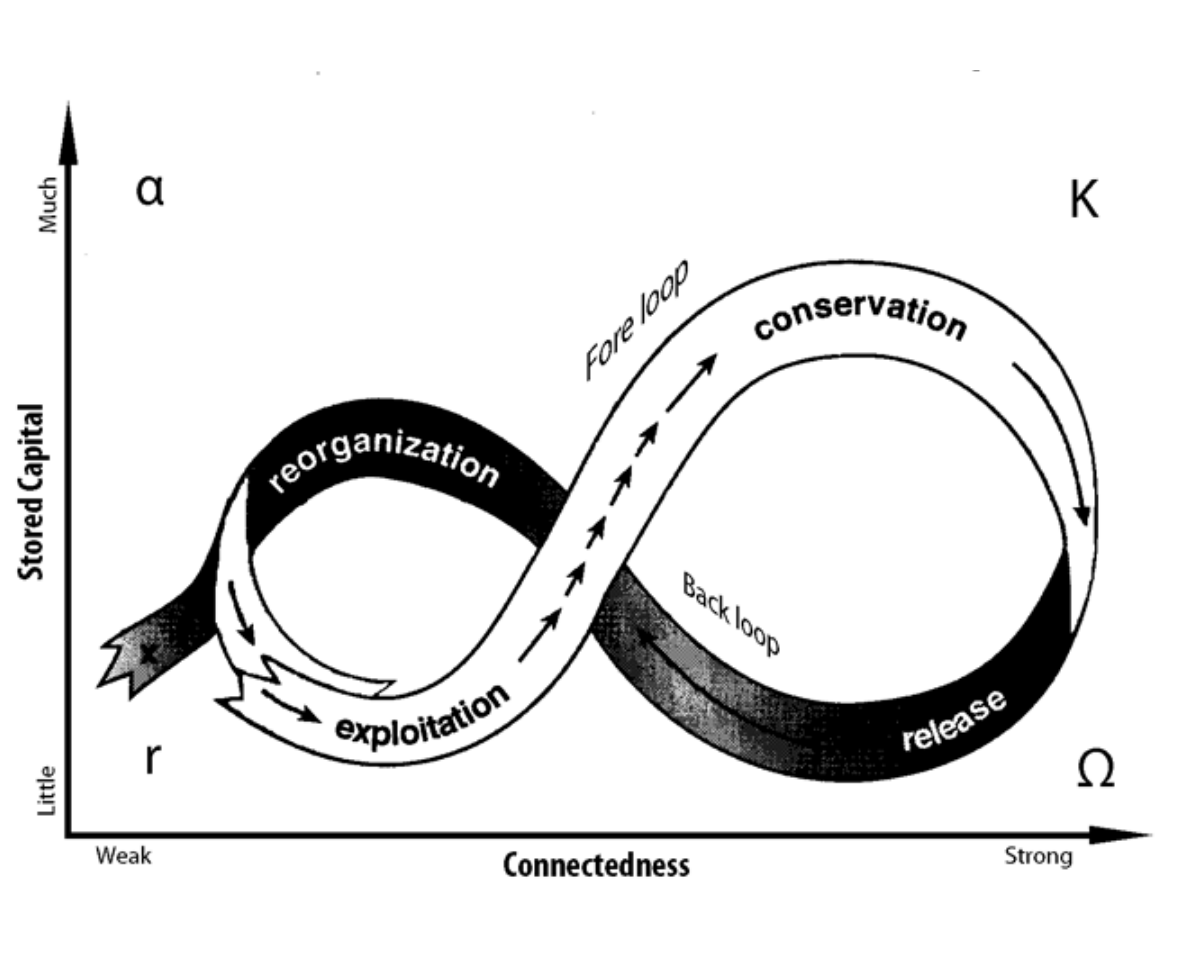
Fig. 1 . The two dimensional representation of the adaptive cycle. The Y-axis reflects the changes in the amount of accumulated capital stored in dominant keystone variables, while the X- axis depicts the degree of connectedness among variables. Following collapse, the system can reorganize and repeat the previous cycle (following a white path) or transform into another system configuration (following a black path). (Source: Adapted from Holling 1987